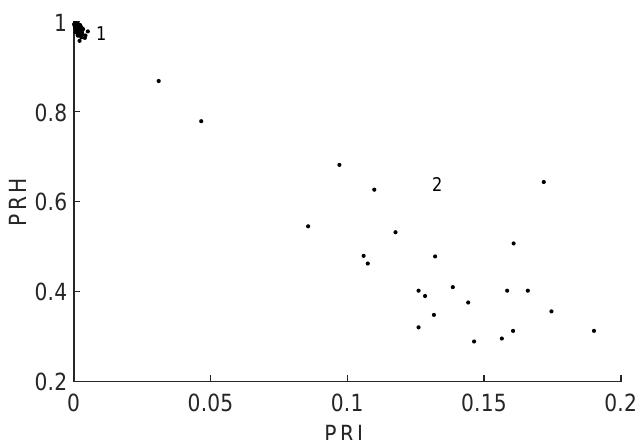
Figure 10. 2D map in which cluster 1 corresponds to FM radio and cluster 2 to partial discharges.